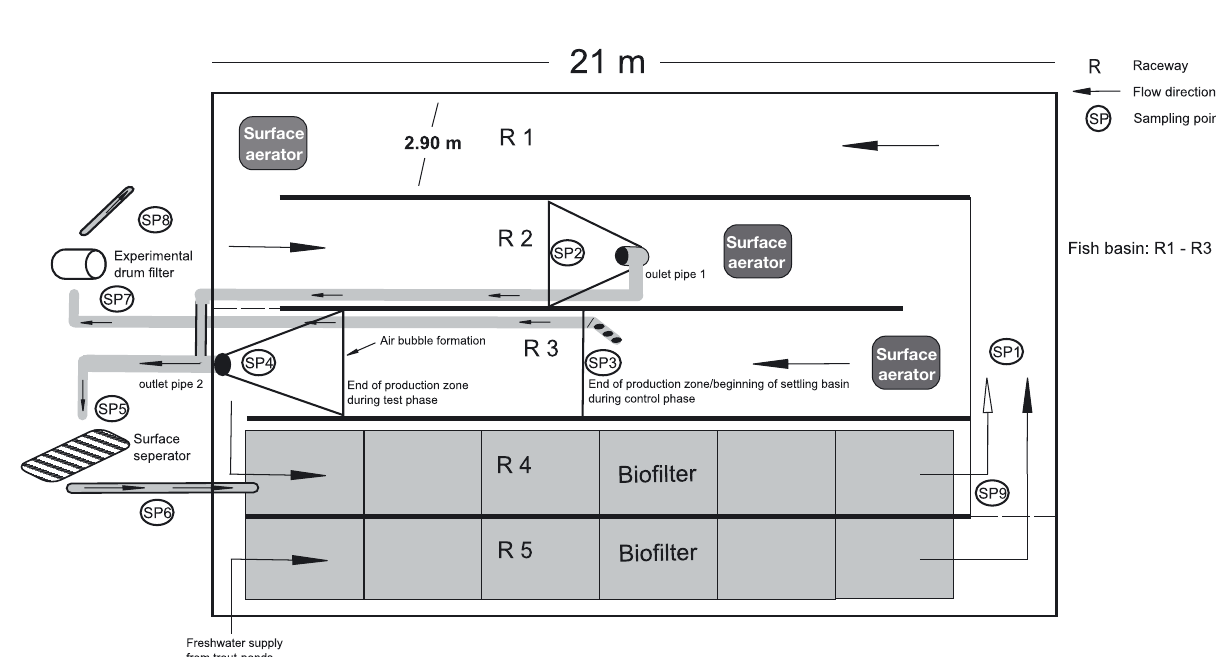
Fig. 1. Diagram of the fish farm, showing raceways (R), aeration units (FAS KR 94/L, 0.37 kW), surface separator settling basin and experimental drum filter (HDF-501-1P). Nine sampling points (SP) for analysis of water physicochemistry are shown as follows: SP1: system inlet, SP2: before outlet pipe 1, SP3: after production zone/before biofilter, SP4: before outlet pipe 2, SP5: before surface separator, SP6: after surface separator, SP7: before drum filter, SP8: after drum filter, SP9: biofilter